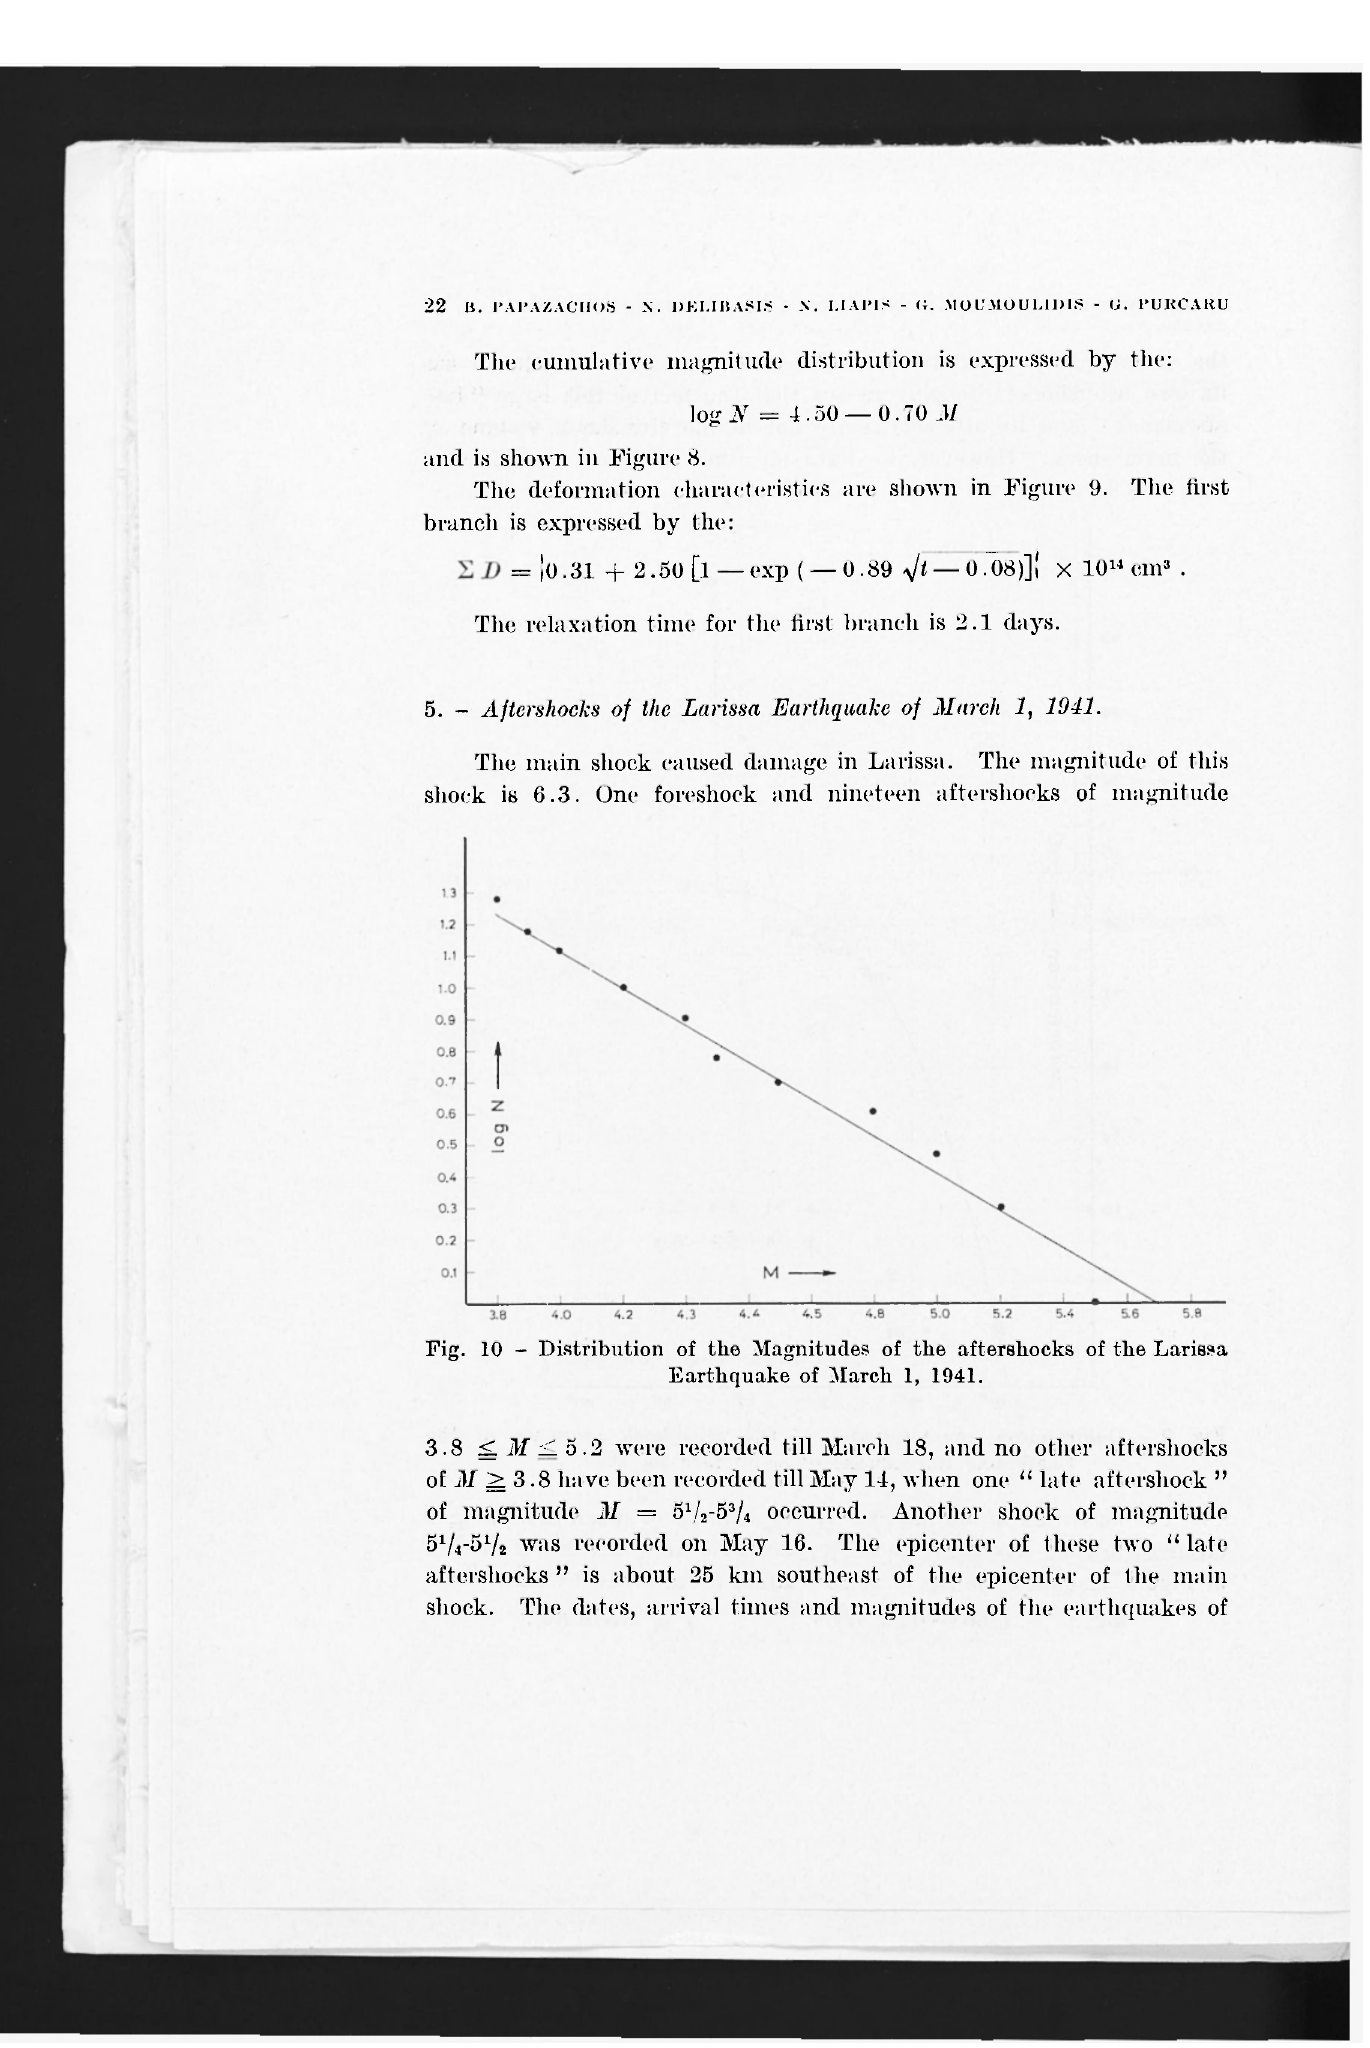
Fig. 10 - Distribution of the Magnitudes of the aftershocks of the Larissa Earthquake of March 1,